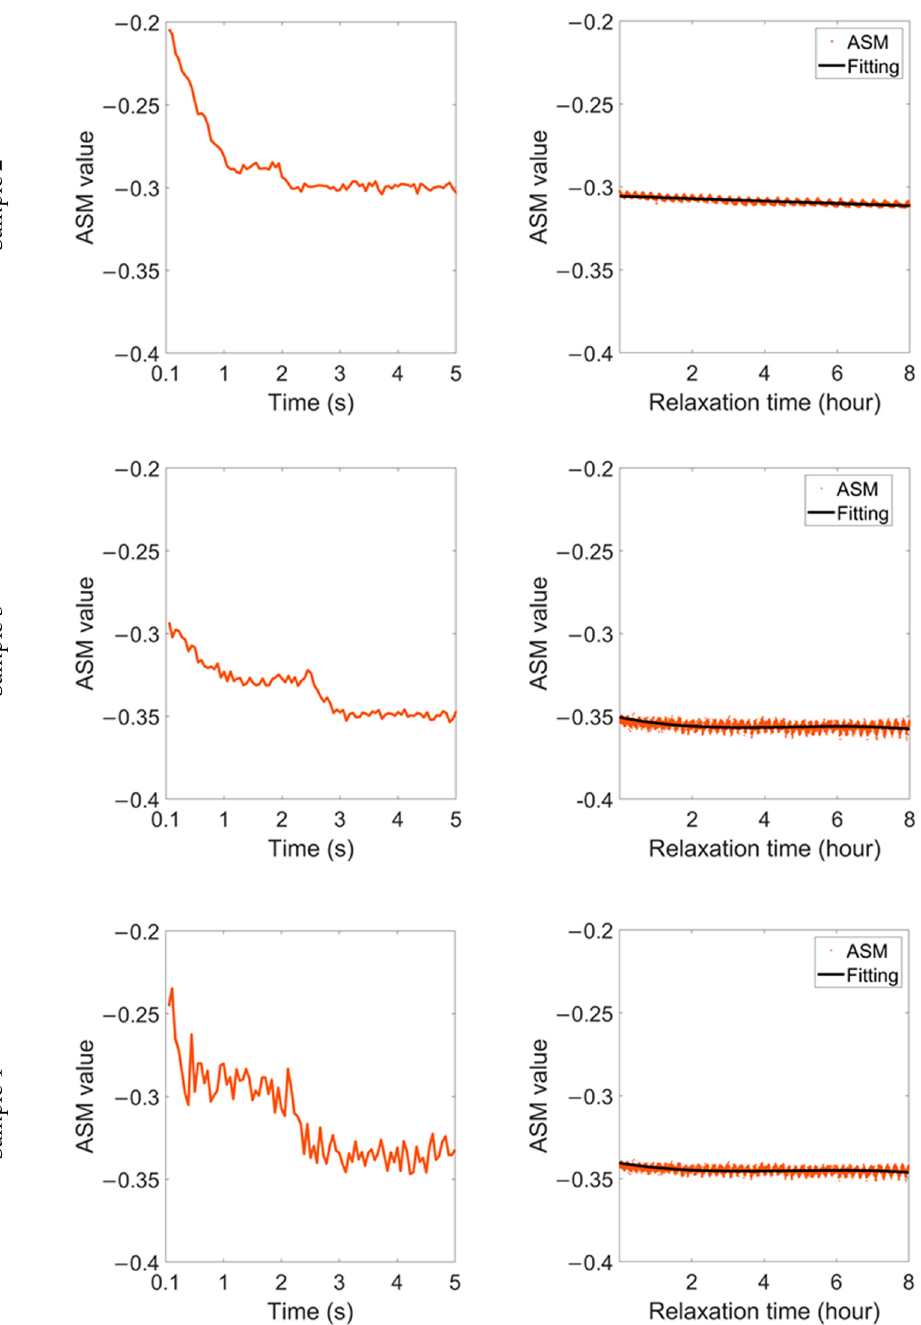
Figure 7. Variation in ASM parameter during relaxation time after 1.5% strain was